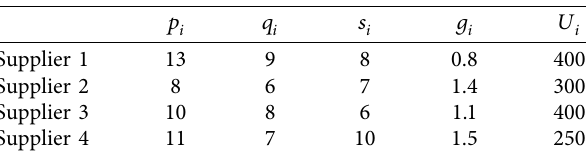
Table 7: Suppliers information.